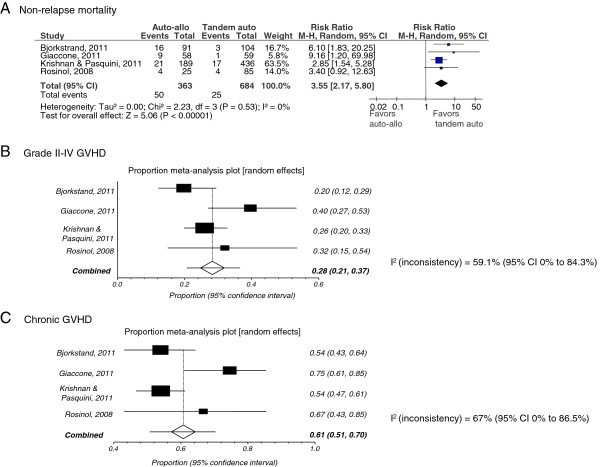
A through 4C: Forest plot for non-relapse mortality (A), grade II-IV graft versus-host disease (B) and chronic graft versus-host disease (C). The summary estimate (risk ratio/proportions) from individual studies is indicated by rectangles with lines representing the 95% confidence intervals (CIs). The summary pooled estimate from all studies is represented by the diamond and the stretch of the diamond indicates the corresponding 95% CI. For the proportional meta-analysis the diamond represents the pooled summary estimates and the 95% CI is indicated by the line.